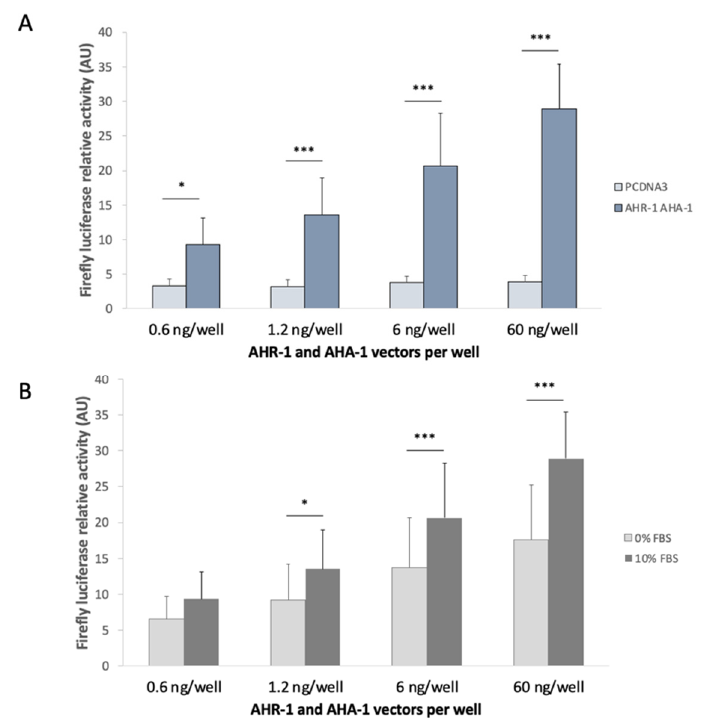
Figure 4. AHR-1 basal activity in Cos-7 cells. Different plasmid concentrations and FBS conditions were tested during the screening model optimization. ( A ) Comparison between the transfection of the empty vector (pcDNA3) and the two partners ( ahr-1 and aha-1 plasmids) in Cos-7 cells cultured with 10% FBS. ( B ) Comparison between the transfection of ahr-1 and aha-1 plasmids in Cos-7 cells cultured either in 0% FBS or in 10% FBS. The relative activity represents the measurement of the Firefly activity normalized to the Renilla measurement for each condition. Six independent experiments were performed in duplicate, error bars represent SD. ANOVA with Bonferroni’s multiple comparison post-test * p -value < 0.05, *** p -value < 0.001.